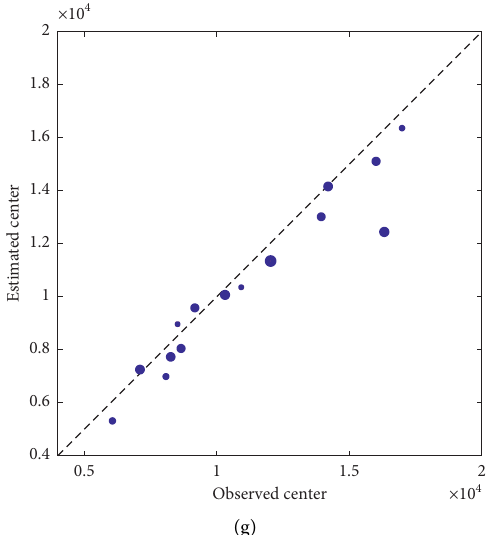
Figure 16: Fuzzy bubble plots in Example 9. (a) Proposed fuzzy bridge regression model with c � 2, (b) the model in [71], (c) the model in [81], (d) the model in [76], (e) the model in [82], (f) the model in [83], and (g) the model in